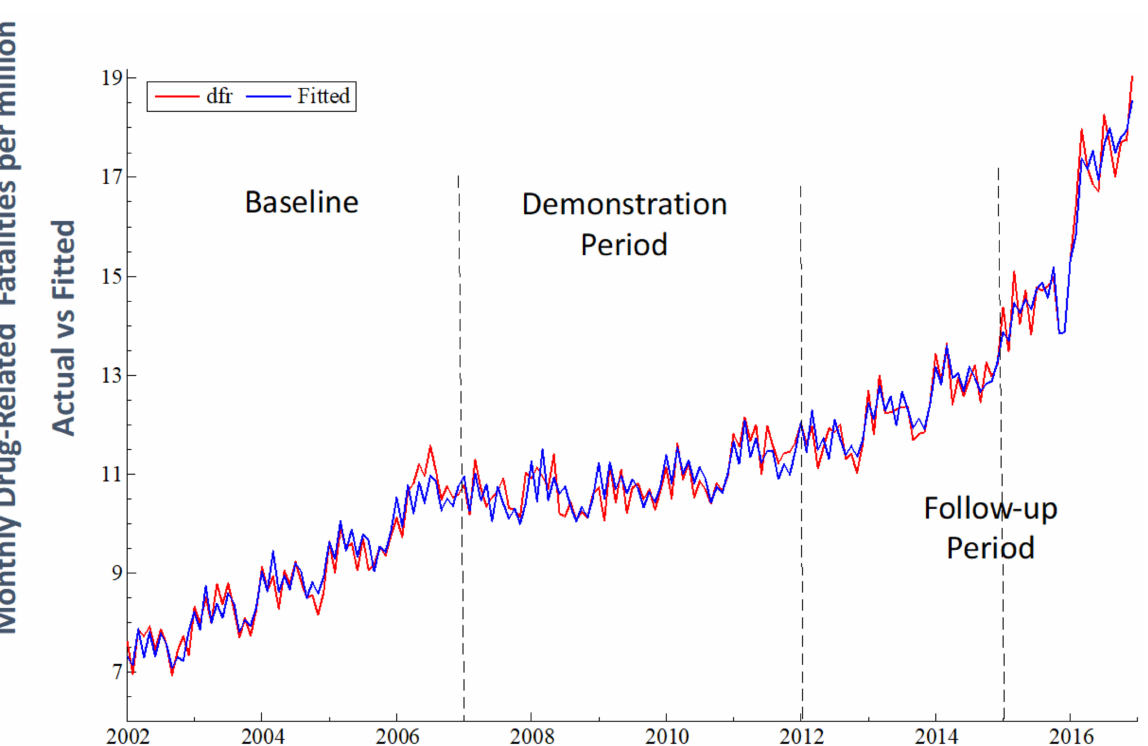
Figure 3. Actual monthly drug-related fatality rate (red) versus regression predicted value (blue) 2002–2016. The squared correlation between the actual and predicted dfr is R 2 =